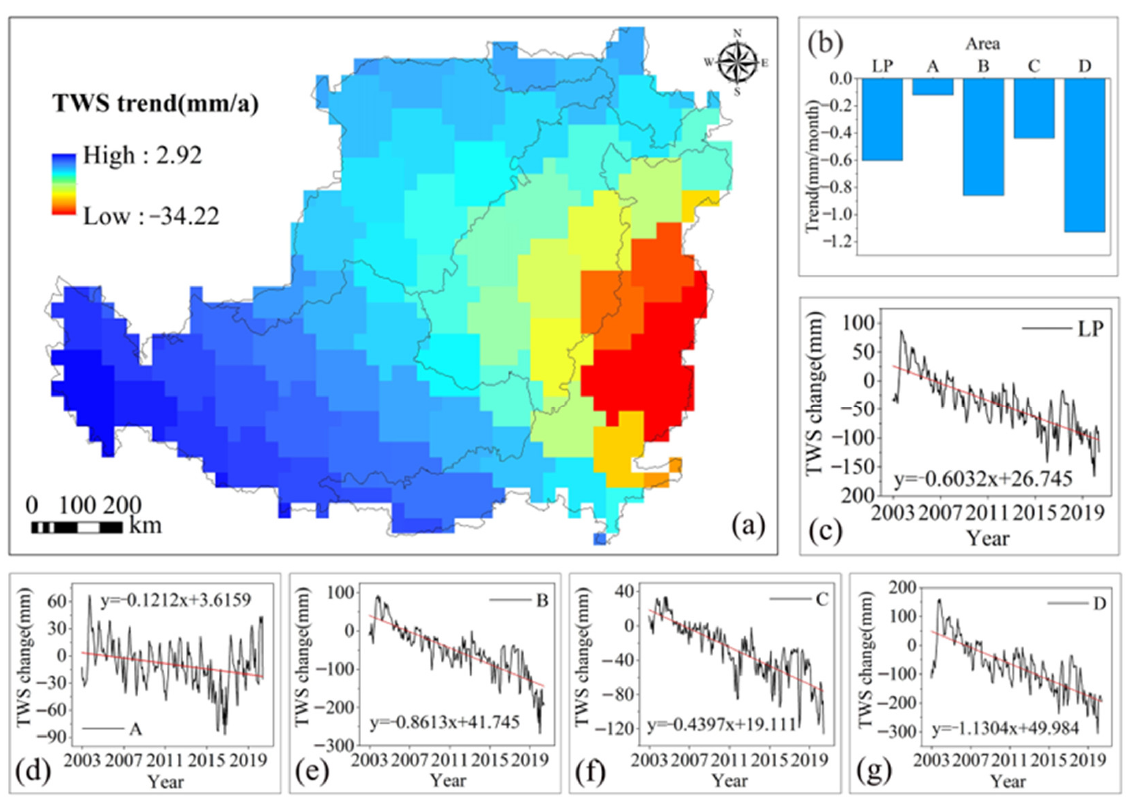
Figure 7. Changes in TWS in the LP from 2003 to 2020: ( a ) spatial changes in TWS in the LP during 2003–2020; ( b ) change rate of TWS in the LP and its subregions; ( c – g ) monthly variation in TWS in the LP and its subregions. Table 3. Pearson correlation coefficient of TWS and vegetation indexes in the LP.